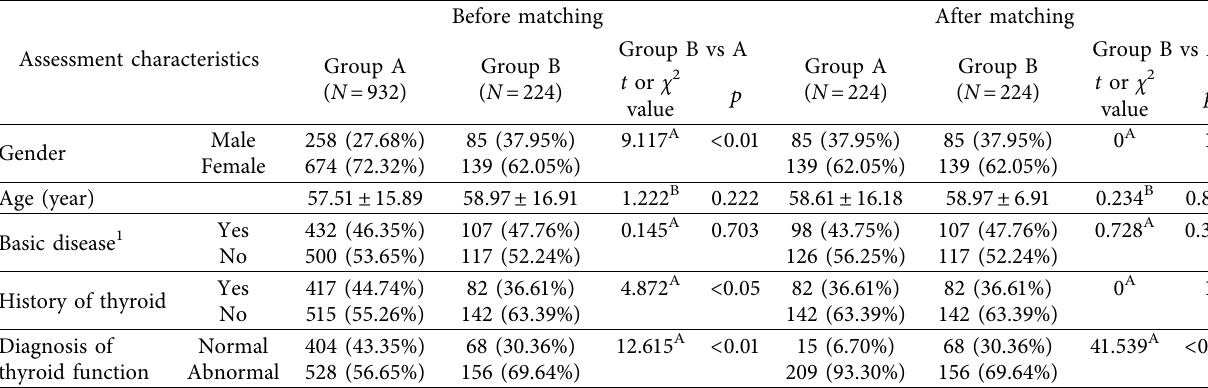
Table 1: Changes in thyroid function during the